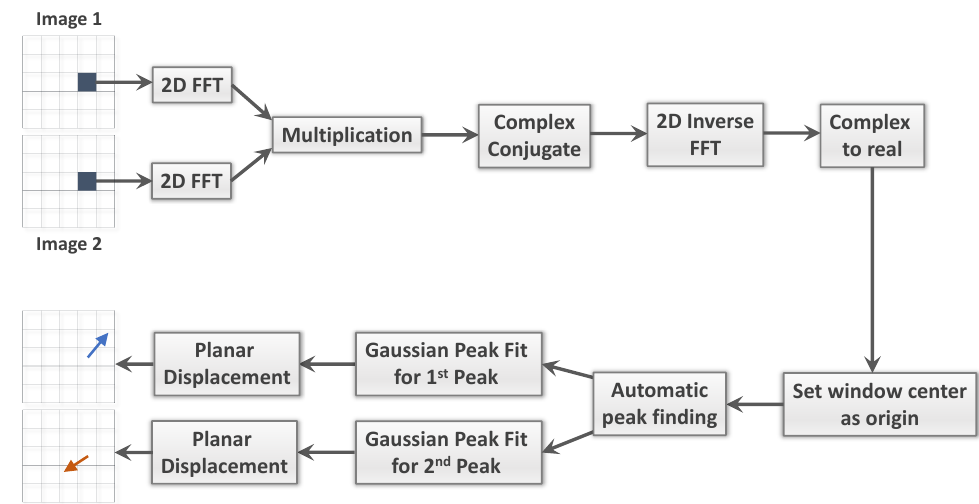
Figure 2. Procedure of the proposed algorithm.